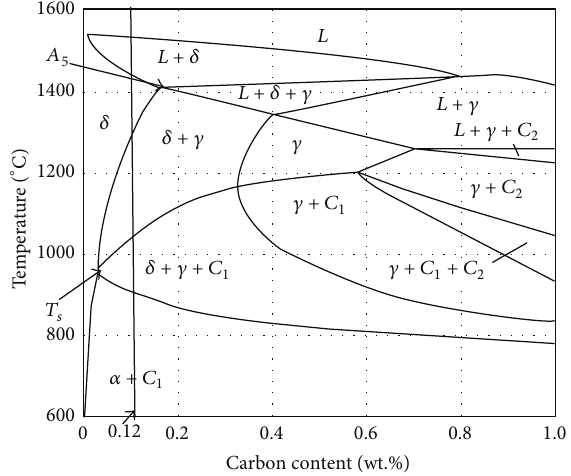
Figure 1: Vertical section of the Fe–Cr–C-ternary diagram at 17wt.% Cr [4].